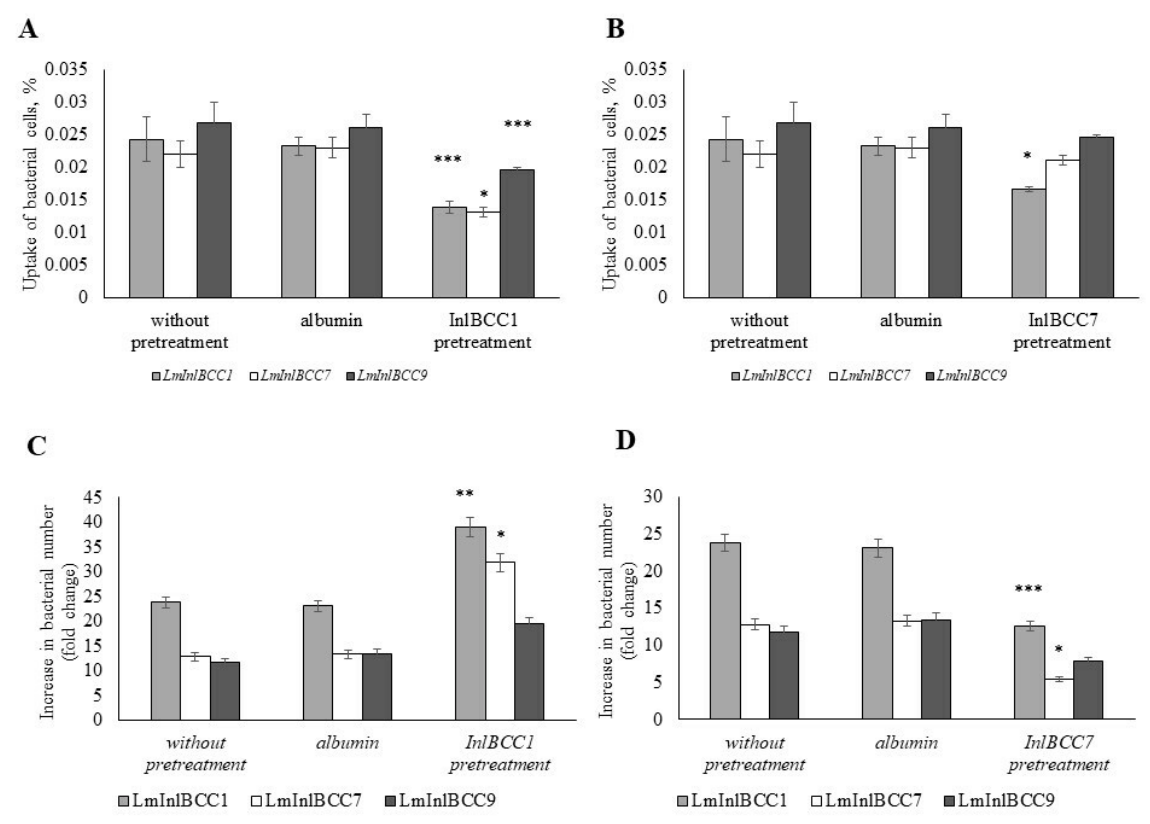
Figure 4. Interaction of M1-phenotype macrophages with isogenic strains of L. monocytogenes after pretreatment with a soluble form of InlB. Macrophages were incubated with soluble isoforms of idInlBs for 15 min. Macrophages were washed three times with PBS. Bacteria were added to the macrophages in MOI 1:100, incubated for 1 h. To destroy extracellular bacteria, gentamicin was added at a concentration of 100 µ g mL − 1 and incubated for 1 h. To assess the effectiveness of bacterial capture, macrophages were washed three times with PBS and 1% triton X-100 were lysed. In the analysis of intracellular reproduction, the medium was replaced with a supportive one with the addition of gentamicin 20 µ g mL − 1 and after 24 h macrophages were washed three times with PBS and 1% triton X-100 were lysed. After cell lysis, serial dilutions were made. The addition of human albumin at a concentration of 1 µ g mL − 1 was used as a control. ( A ) The uptake of isogenic recombinant strains of L.monocytogenes into M1-phenotype macrophages with pretreatment idInlB CC1 (*** p < 0.001, * p < 0.05, n = 4); ( B ) The uptake of isogenic recombinant strains of L.monocytogenes into M1-phenotype macrophages with pretreatment idInlB CC7 (* p < 0.05, n = 4); ( C ) An increase in the number of bacteria of isogenic strains of L. monocytogenes in macrophages of M1-like phenotype with pretreatment idInlB CC1 within 24 h after infection (** p < 0.01, * p < 0.05, n = 4); ( D ) An increase in the number of bacteria of isogenic strains of L. monocytogenes in macrophages of M1-like phenotype with pretreatment idInlBCC1 within 24 h after infection (*** p < 0.001, * p < 0.05, n = 4).